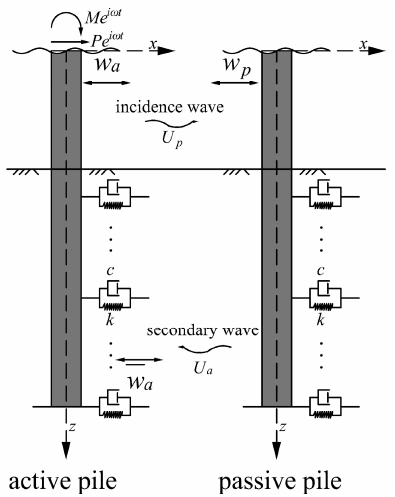
Figure 3. Pile–pile interaction.